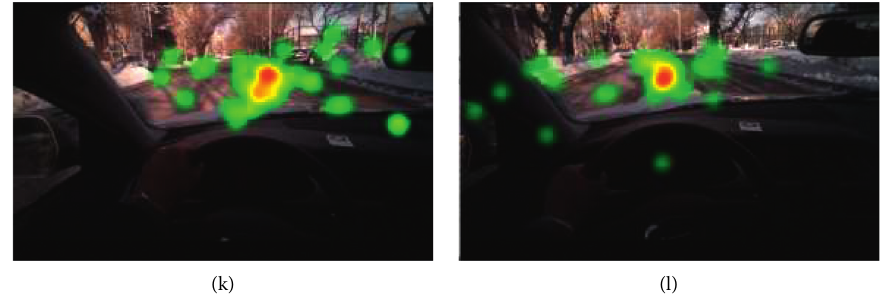
Figure 7: Distribution of the hot spots in the area of interest of the participant: (a) normal driving in event one, (b) distracted driving (one- back) in event one, (c) distracted driving (two-back) in event one, (d) distracted driving (clock task) in event one, (e) normal driving in event two, (f) distracted driving (one-back) in event two, (g) distracted driving (two-back) in event two, (h) distracted driving (clock task) in event two, (i) normal driving in event three, (j) distracted driving (one-back) in event three, (k) distracted driving (two-back) in event three, and (l) distracted driving (clock task) in event